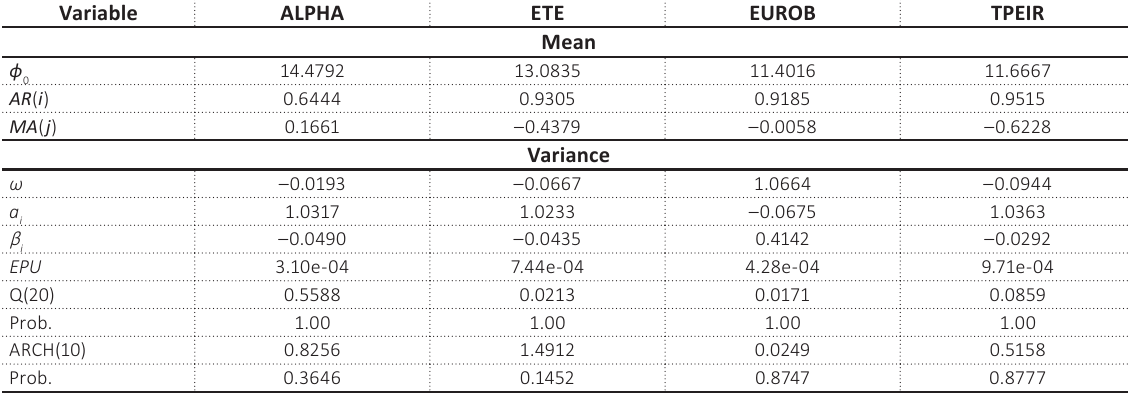
Table 2. Parameter estimates for the marginal distribution of